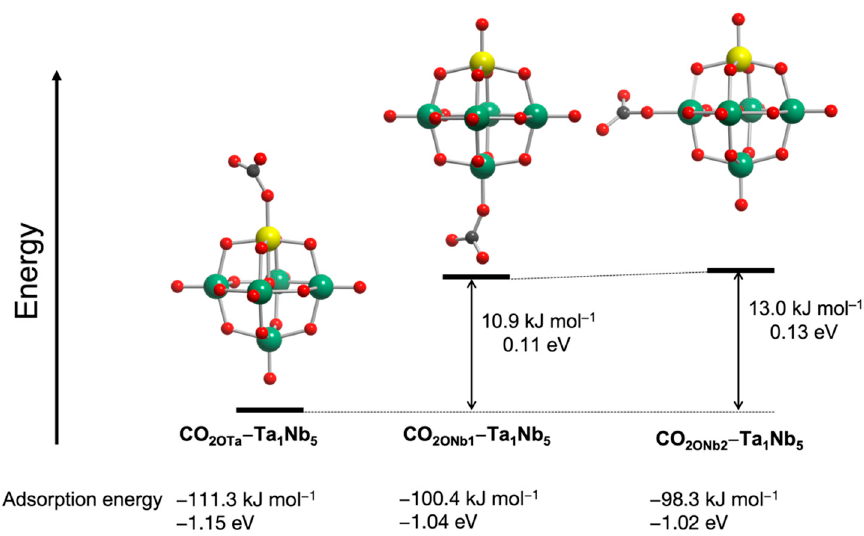
Figure 6. NBO charge of surface O sites of [Ta x Nb 6 − x O 19 ] 8 − . Color codes: yellow atom, Ta; green atom, Nb; blue line, Ta-coordinated O atoms; green line, Nb-coordinated O atoms; red, total O atoms. Red circle represents the averaged value. Terminal and bridging O atoms represent solid and dashed lines, respectively.